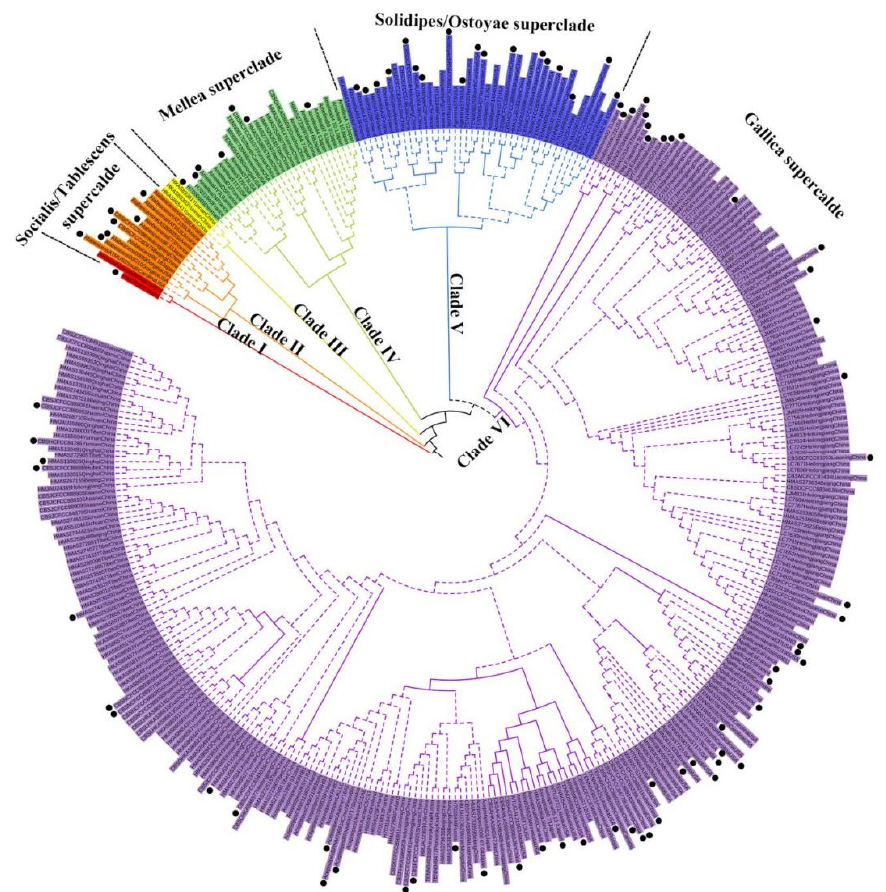
Figure 1. Phylogenetic tree of 358 Armillaria and Desarmillaria samples inferred from maximum likelihood and Bayesian analyses based on Dataset I (ITS+IGS-1+TEF-1 α ). Only bootstraps (LB) over 70% and Bayesian posterior probabilities (PPs) over 0.95 are shown on the branches. The samples labeled with black dots were chosen for the species delimitation analysis presented in Figure